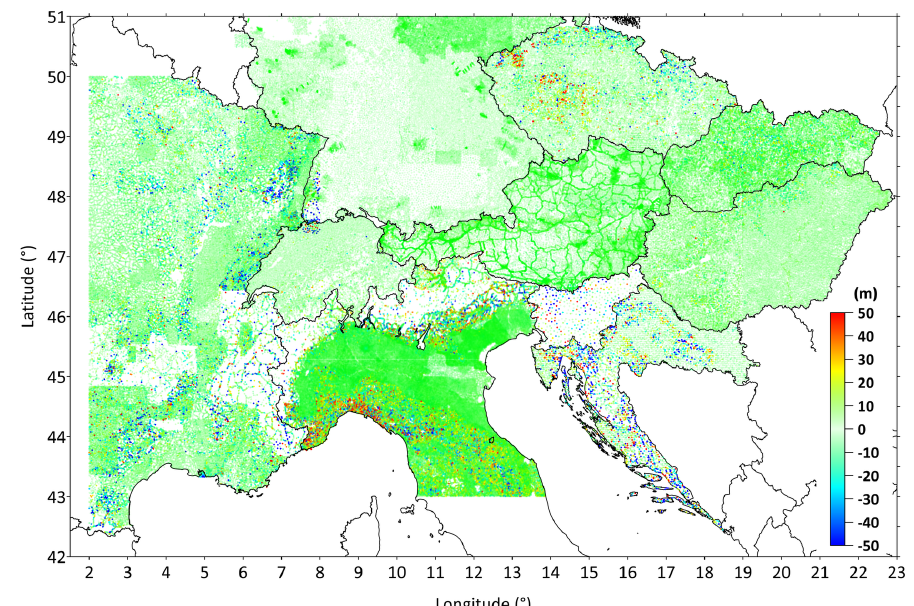
Figure C1. Height differences (in meters) for DEMs in the “inner zone” of the TOPOSK software (refer to Appendix D) between the used DEMs and the heights of these